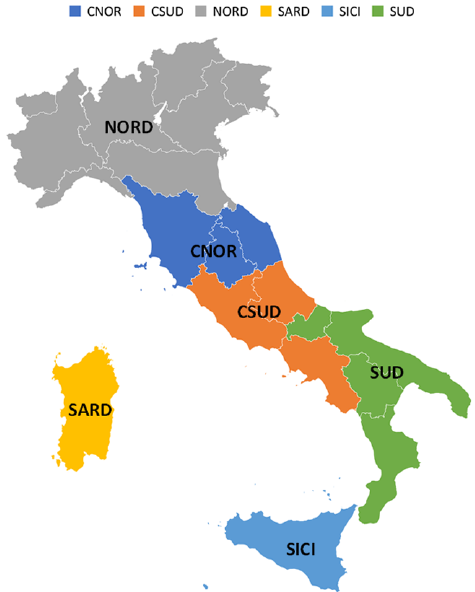
Figure 1. Map of the Italian geographic zone (starting from 1 January 2021, Calabria is operated as a new geographical zone. The introduction of the Calabria as a geographical zone brings the number of geographical zones from 6 to 7 zones) [4].